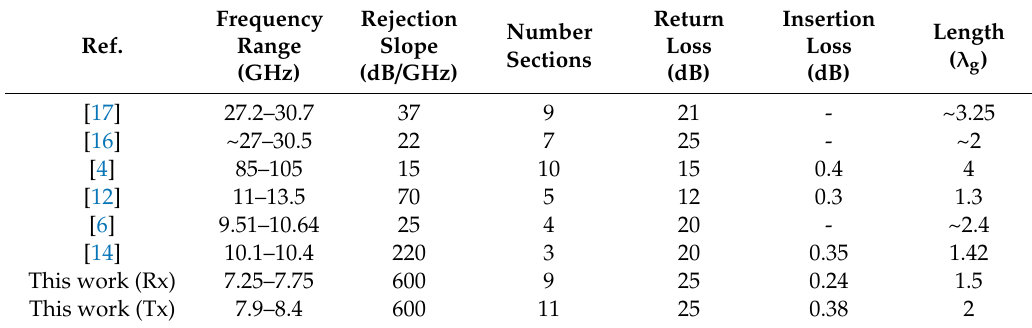
Table 3. Comparison between performances of proposed filters and other related works found in the literature.